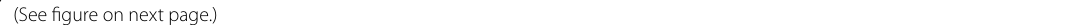
figure on next Fig. 2 Male patient 43 years old with chronic viral hepatitis C and HCC in segment VIII diagnosed as HCC. He underwent RFA; follow-up MRI study was done after 12 weeks after ablation revealed high ADC value and no diffusion restriction in a non-viable ablated bed. The lesion showed an isointense signal at T1WI ( a ), hypointense signal at T2WI ( b ), at DCE-MRI “arterial ( c ), portal ( d ) and delayed ( e ) series” showed no significant enhancement, DWI at b value 500 ( f ) and 800 ( g ) showed no restricted diffusion, with a corresponding high signal at ADC series ( h ) (ADC value 1.35 10 − 3 mm 2 = ×